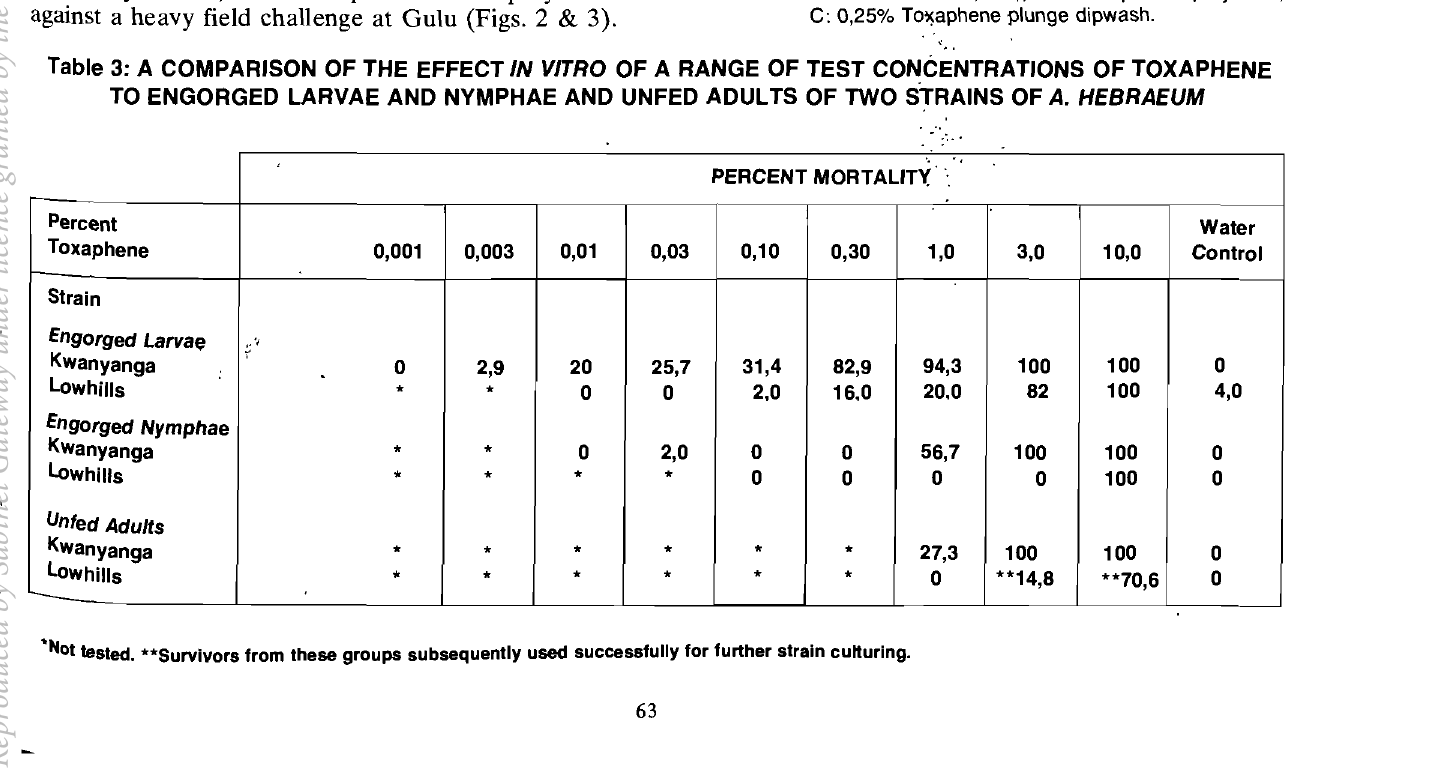
Fig, 2 A comparison of the assessments of A. hebraeum nymphs on groups of cattle at 'Tarbet' and 'Gulu' before and 2 days after